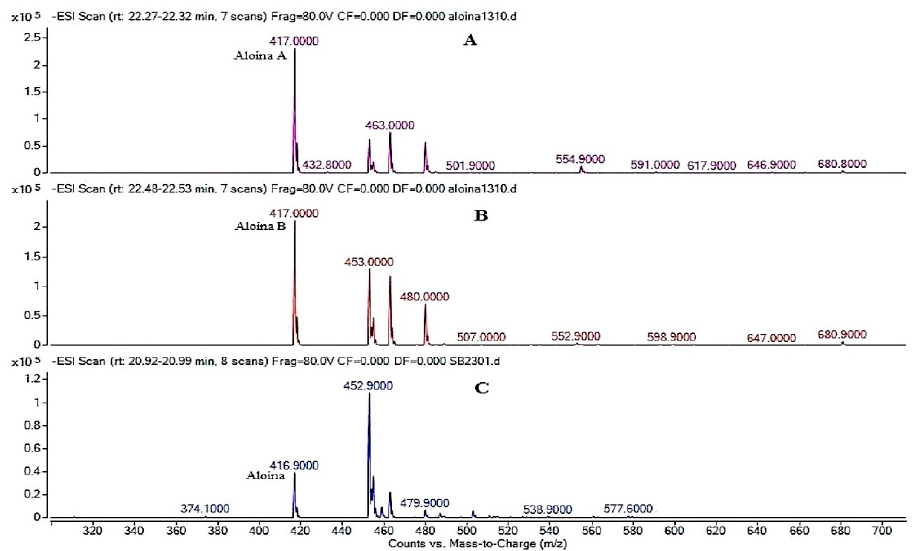
Figure 2. Mass spectrum of Aloin A ( A ), Aloin B ( B ), and EA ( C ).